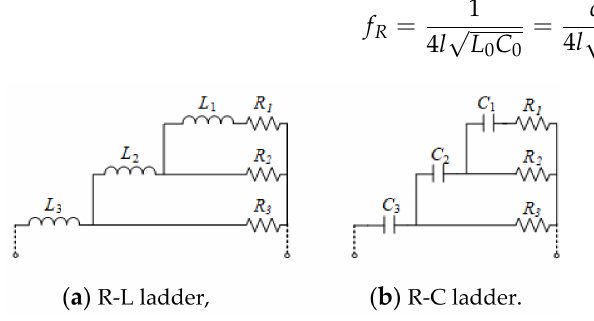
Figure 2. Elementary cell of the ladder network.